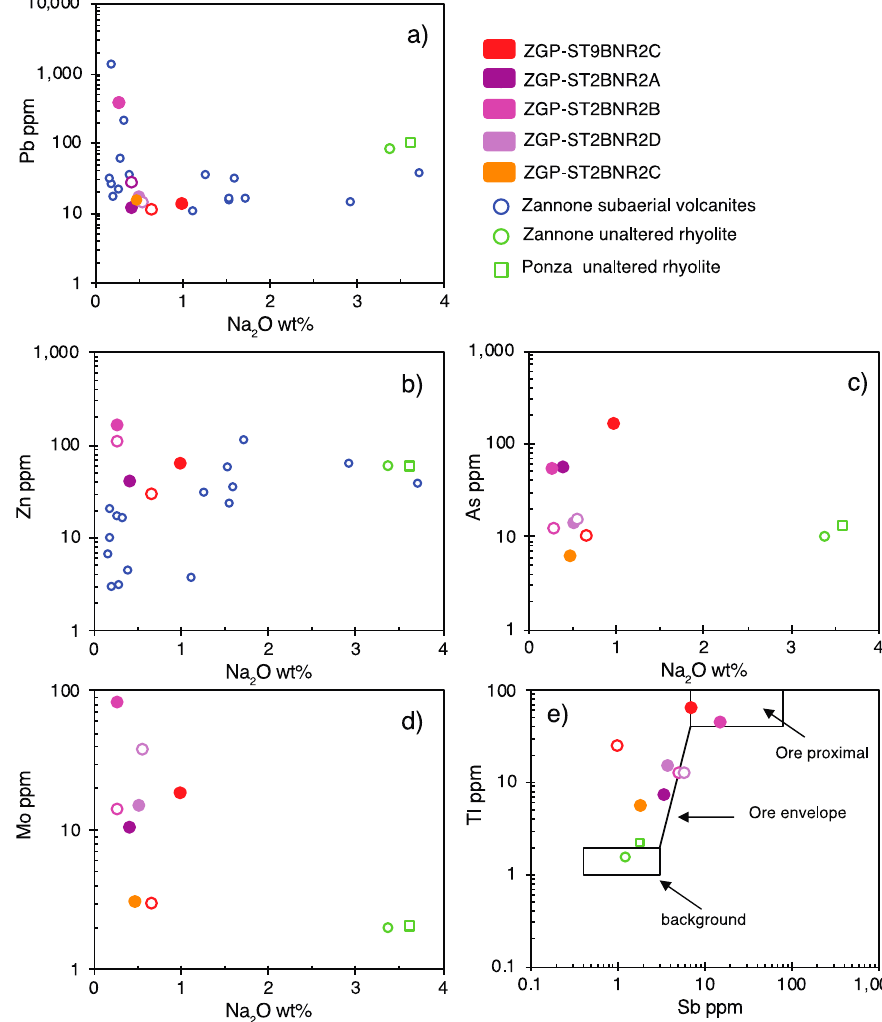
Figure 14. ( a – d ) Correlation plots of Na 2 O against selected base metal elements and As. ( e ) Relationship between Sb and Tl diagram for di ff erently hydrothermal altered ZGP rhyolite clasts. The fields are from Large et al. [22]. Here and in Figure 15, Zannone subaerial volcanites are from Conte and Dolfi [26]. Data of unaltered Zannone and Ponza volcanics are from Conte et al. [28]. Symbols of ZGP clasts: full—inner portion, empty—outer portion.